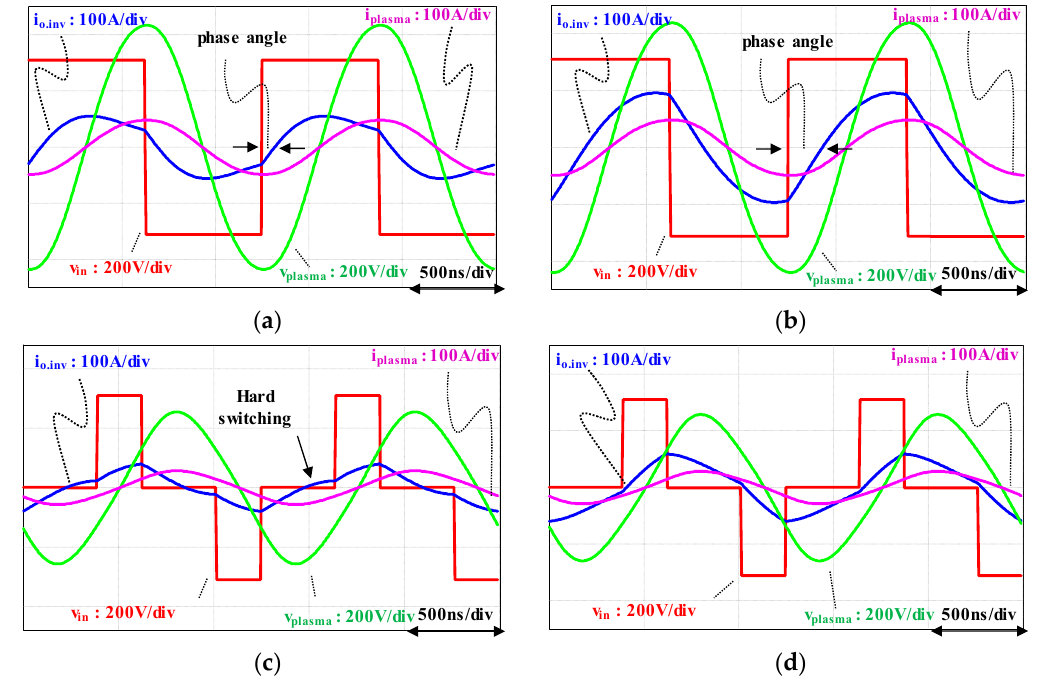
Figure 8. Simulation waveform of each resonant network: ( a ) characteristics of the LCL network under the 9 Ω , 35 A output conditions; ( b ) characteristics of the LCCL network under the 9 Ω , 35 A output conditions; ( c ) characteristics of the LCL network under the 9 Ω , 20 A output conditions; and ( d ) characteristics of the LCCL network under the 9 Ω , 20 A output conditions. Energies 2019 , 12 , x FOR PEER REVIEW